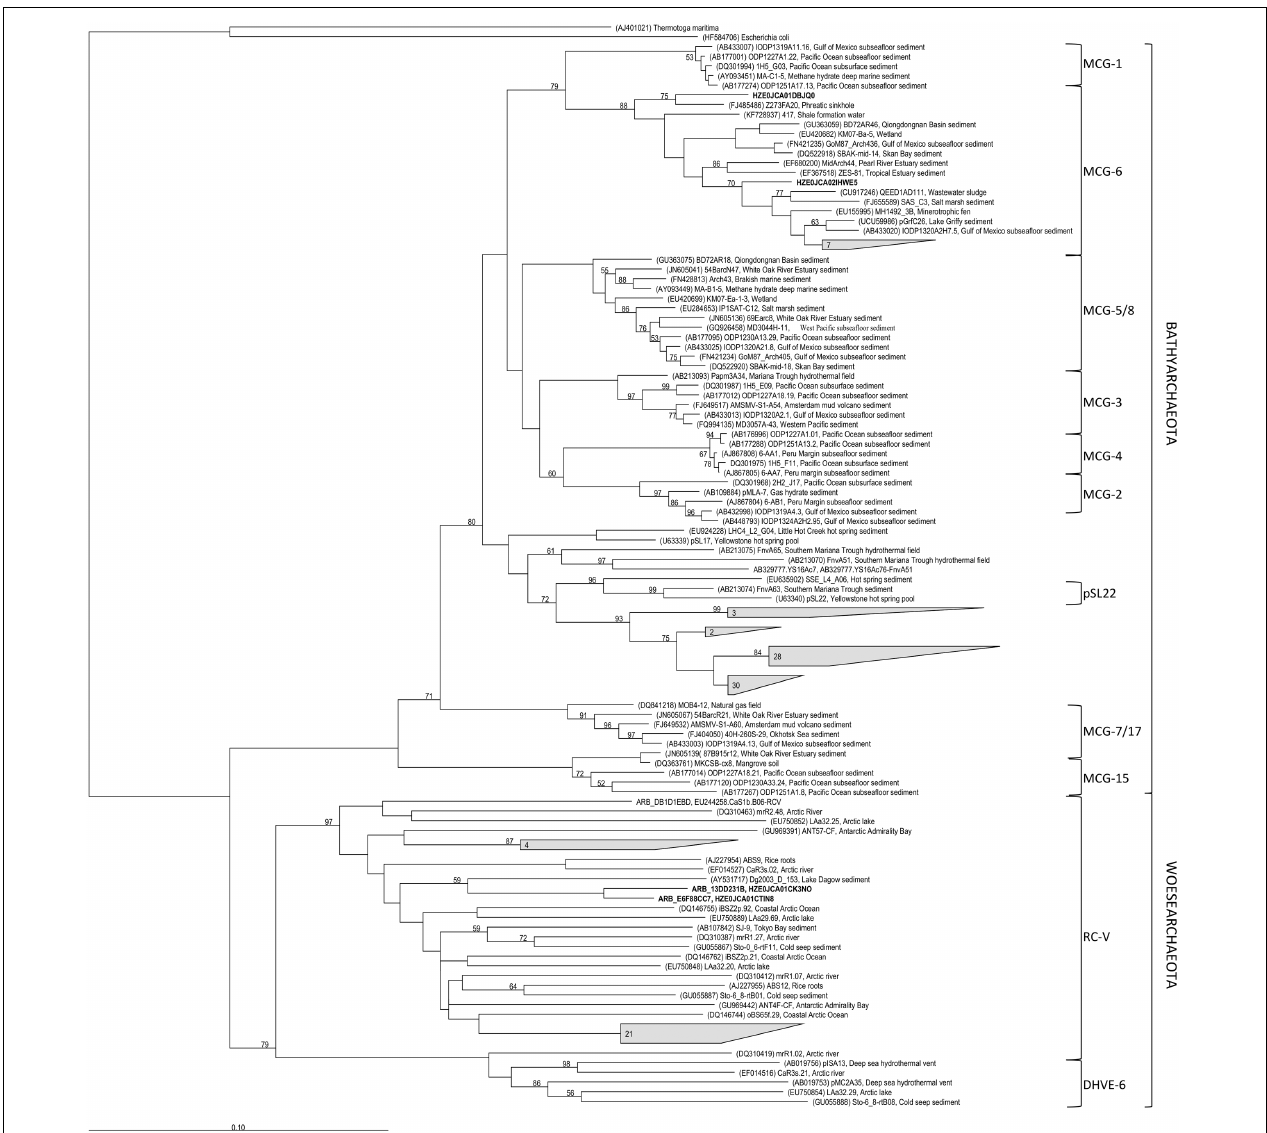
FIGURE 3 | Phylogenetic affiliation of Bathyarchaeota and Woesearchaeota 16S rRNA gene sequences from soils along the Franz Josef chronosequence (in bold or grouped as gray-shaded form including the number of the respective sequences). Bootstrap values (in percent) are based on 1000 replicates (values below 50% are not shown). The scale bar indicates 10% estimated phylogenetic